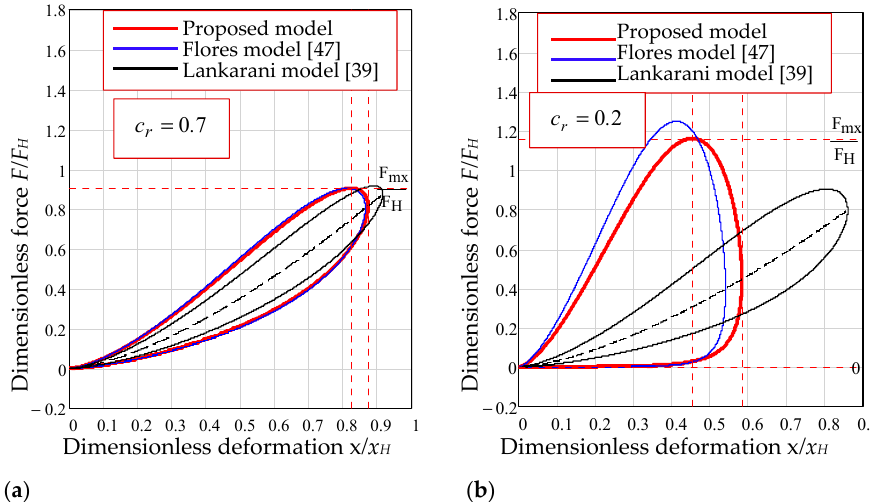
Figure 20. Phase portrait for the three models: ( a ) c r = 0.7 and ( b ) c r = 0.2.